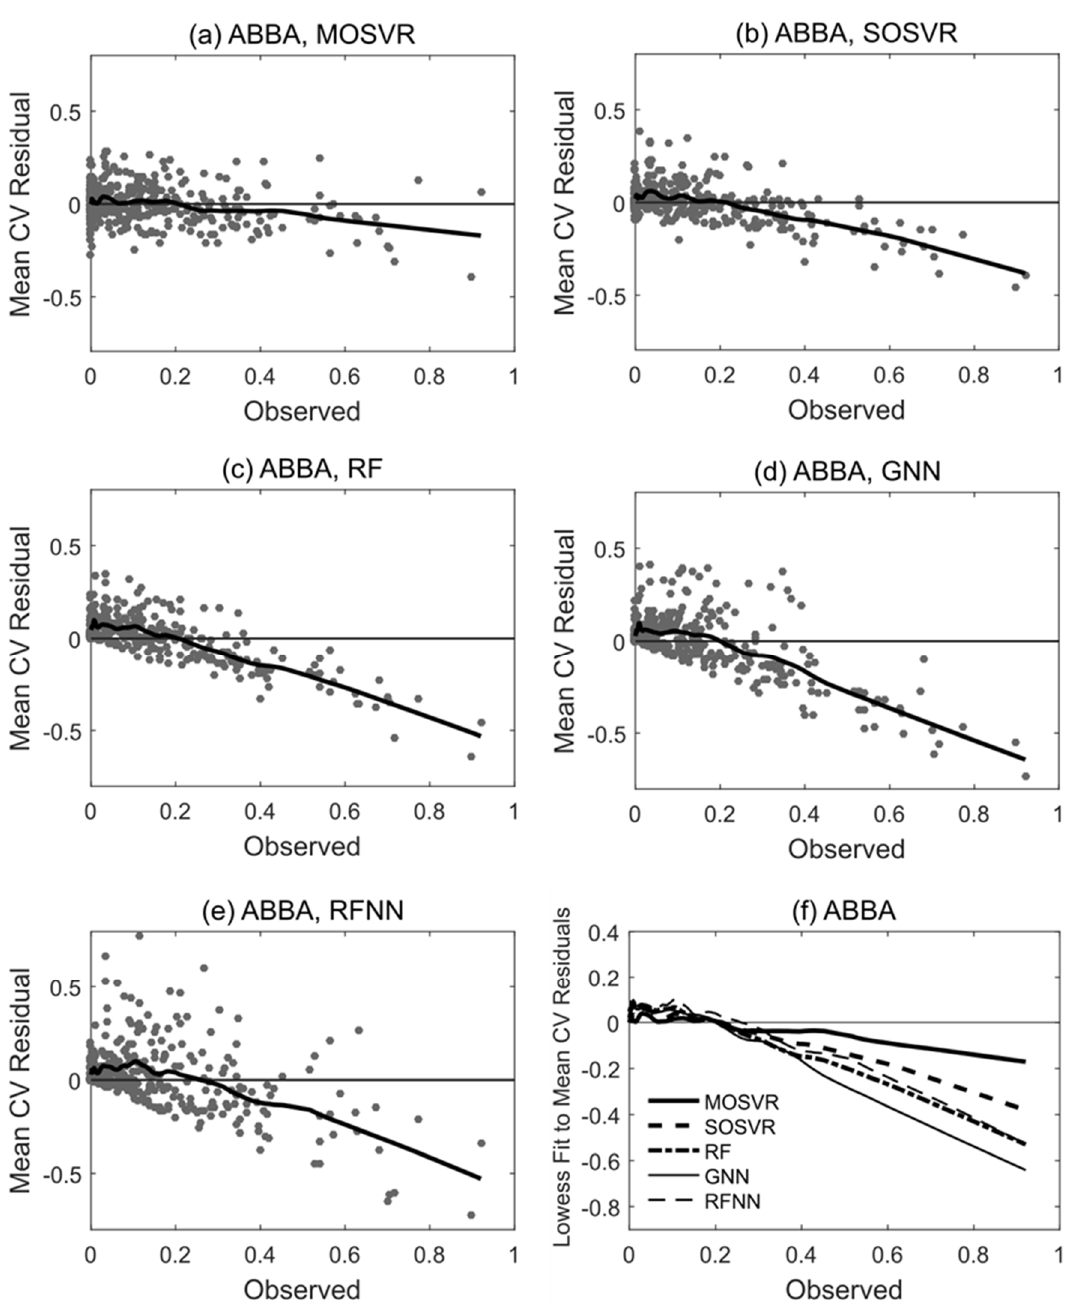
Figure 6. Trends in residual values for selected model types fit to species ABBA (balsam fir). Residuals plotted against observed values for ( a ) MOSVR, ( b ) SOSVR, ( c ) RF, ( d ) GNN, and ( e ) RFNN model types. Residual values are mean values obtained from 100 repetitions of a 10-fold CV, displayed with lowess curves (local weighted least squares regression of a first degree polynomial, spanning 20% of samples). ( f ) Lowess curves fit to residual plots for direct comparisons between model types.